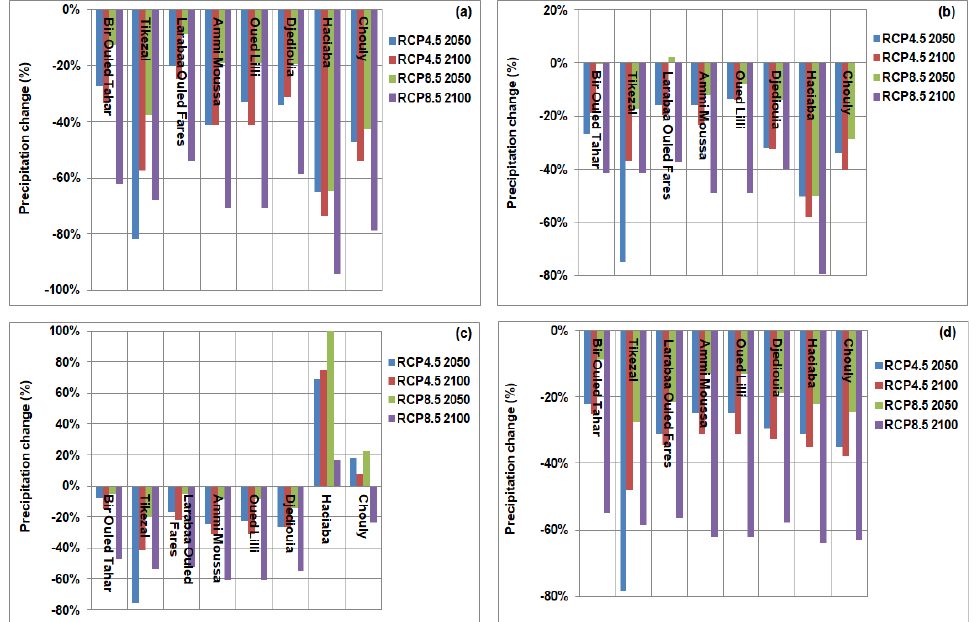
Figure 6. Changes in spring precipitation relative to the historical period under two scenarios (RCP4.5 and RCP8.5): ( a ) quantile mapping, ( b ) scaled distribution mapping, ( c ) quantile delta mapping, and ( d ) RAW.